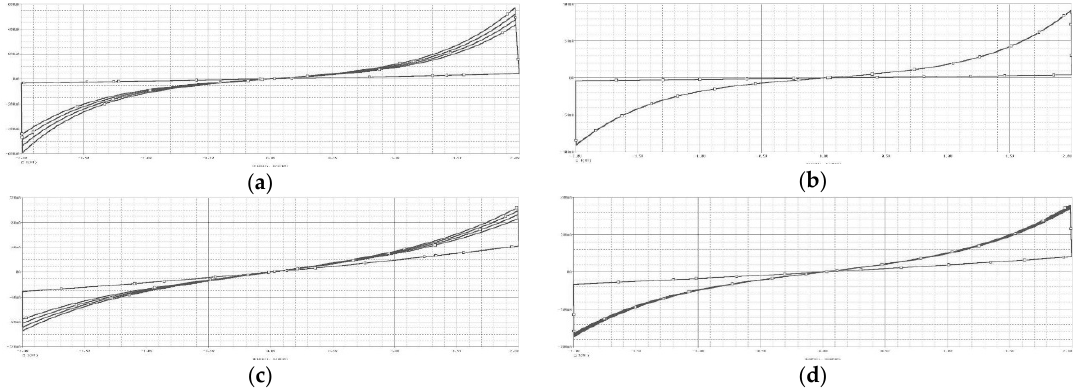
Figure 5. Time diagrams of the memristor voltage, state variable, and memristance for: ( a ) Biolek modified window function; ( b ) Joglekar modified window function; ( c ) Biolek original window function; ( d ) Joglekar original window function.